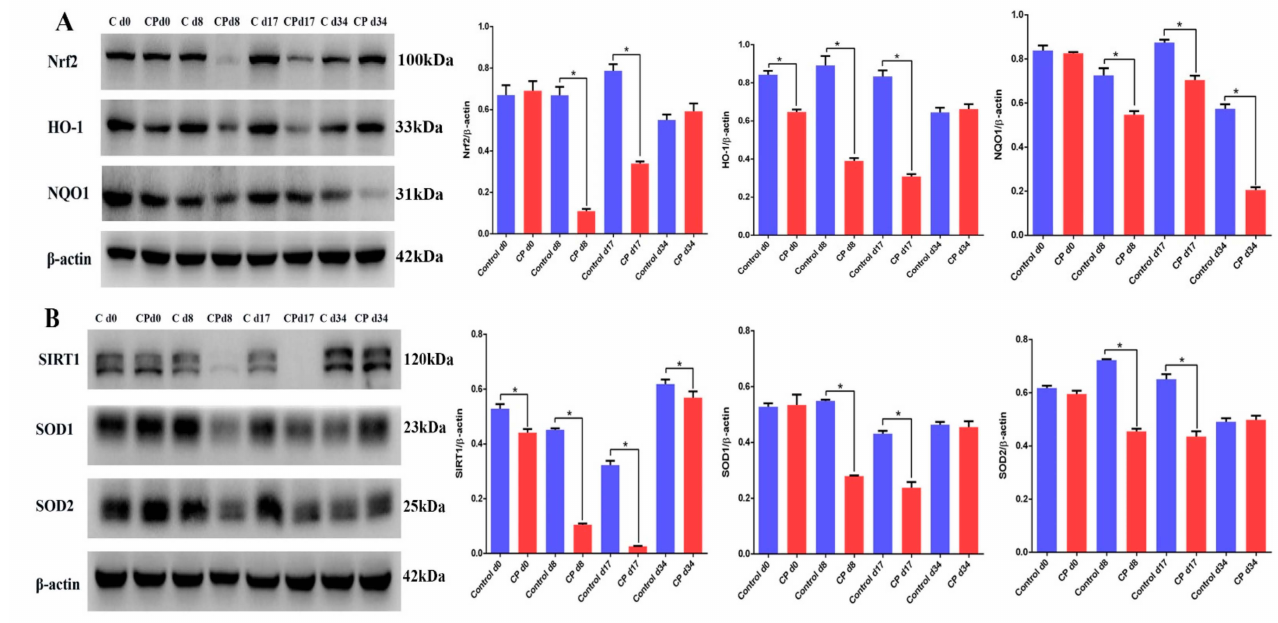
Figure 4. Cisplatin attenuates the expression of SIRT1/Nrf2 signaling at different recovery times. ( A ) Determination of Nrf2, HO-1, and NQO1 protein levels performed by Western blotting in mouse testes from the different groups. The blots were analyzed using Image J software. ( B ) Determination of the SIRT1, SOD1, and SOD2 protein levels performed by Western blotting in mouse testes from the different groups. The blots were analyzed using Image J software. CP, cisplatin. Data are presented as the mean ± SEM ( N = 3–6 per group). * p < 0.05 compared with